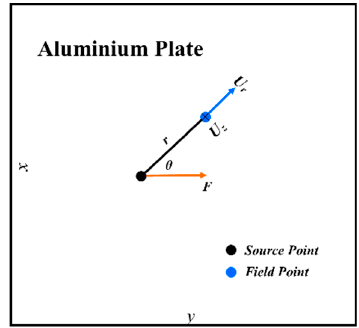
Figure 11. The model used to simulate Rayleigh waves. Reproduced with permission from [18], Elsevier, 2017.